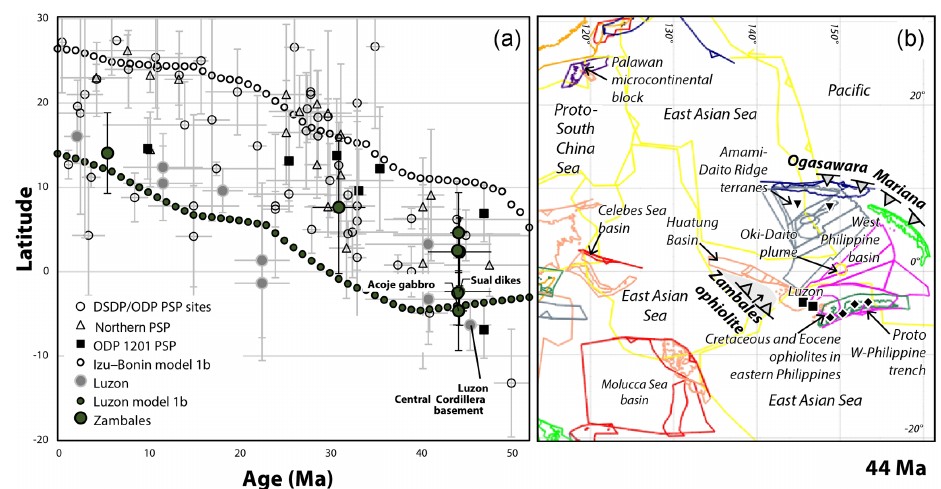
Figure 10. (a) Paleolatitudes derived from Philippine Sea plate, Luzon and Zambales inclination data (Fuller et al., 1991; Hall et al., 1995; Queano et al., 2007, 2009; Richter and Ali, 2015; Yamazaki et al., 2010). (b) Tectonic reconstruction of the western Pacific region at 44Ma using GPlates (Boyden et al., 2011) and unfolded slab data, plate polygons and the rotation files (model 1b) of Wu et al. (2016). Inverted triangles, diamonds and squares previously shown in Fig. 1b. refer to Cretaceous arc terranes in the northern Philippine Sea plate and Cretaceous–Eocene ophiolites in eastern Philippines,